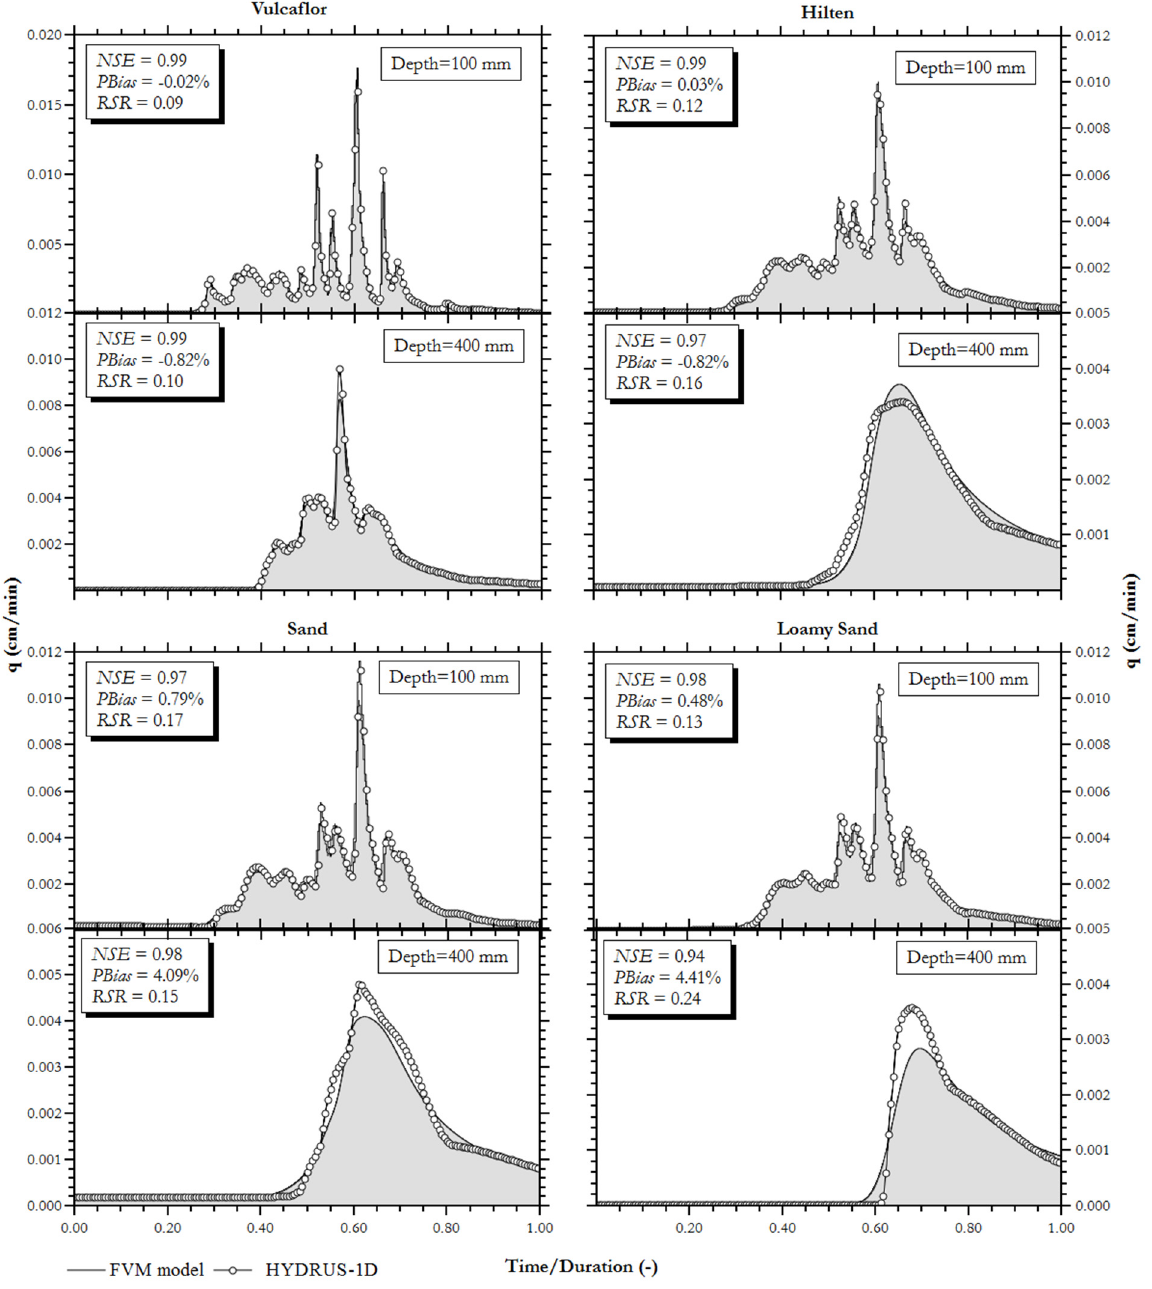
Figure 7. Graphical and statistical evaluations of comparing the proposed model soil outflow rates to those produced by Hydrus-1D, for the event of 29 November 2013 22:19:00 and the Vulcaflor